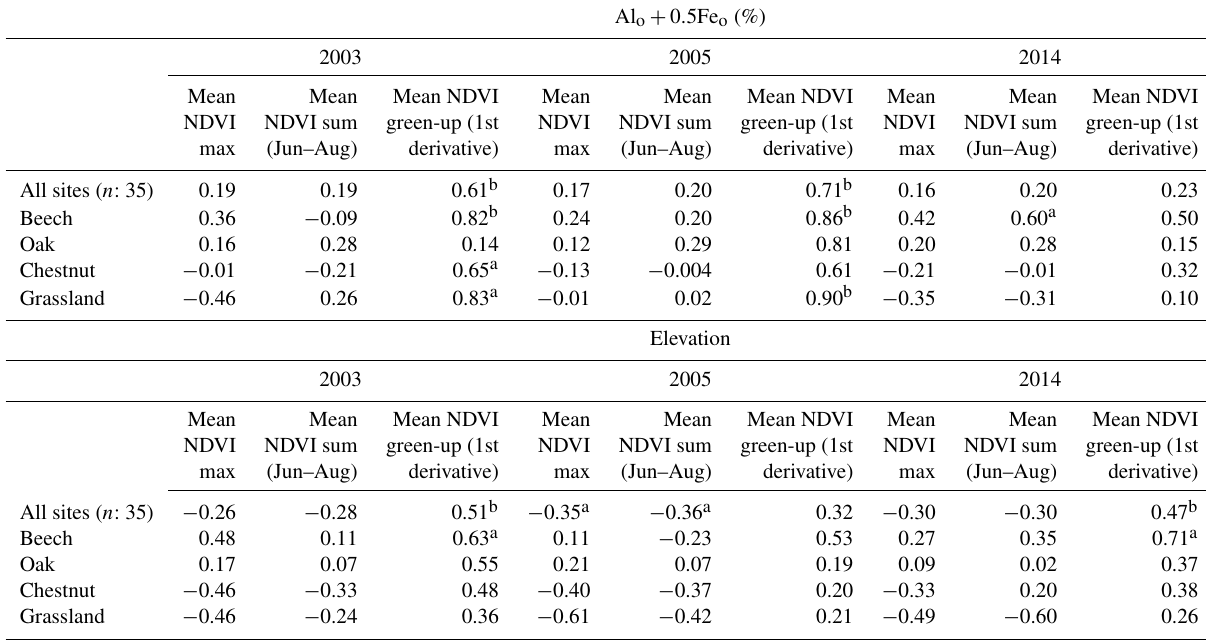
Table 4. Bivariate correlation